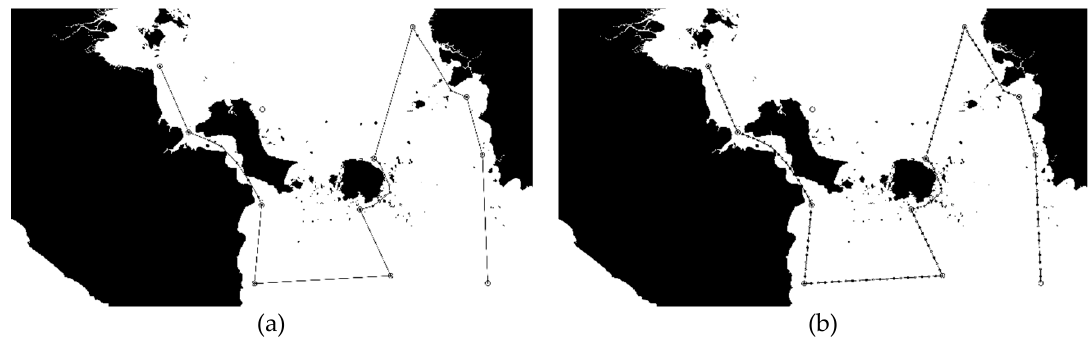
Figure 2. The global path planning results ( a ) the task execution sequence after task planning, and ( b ) the refined global path after global path